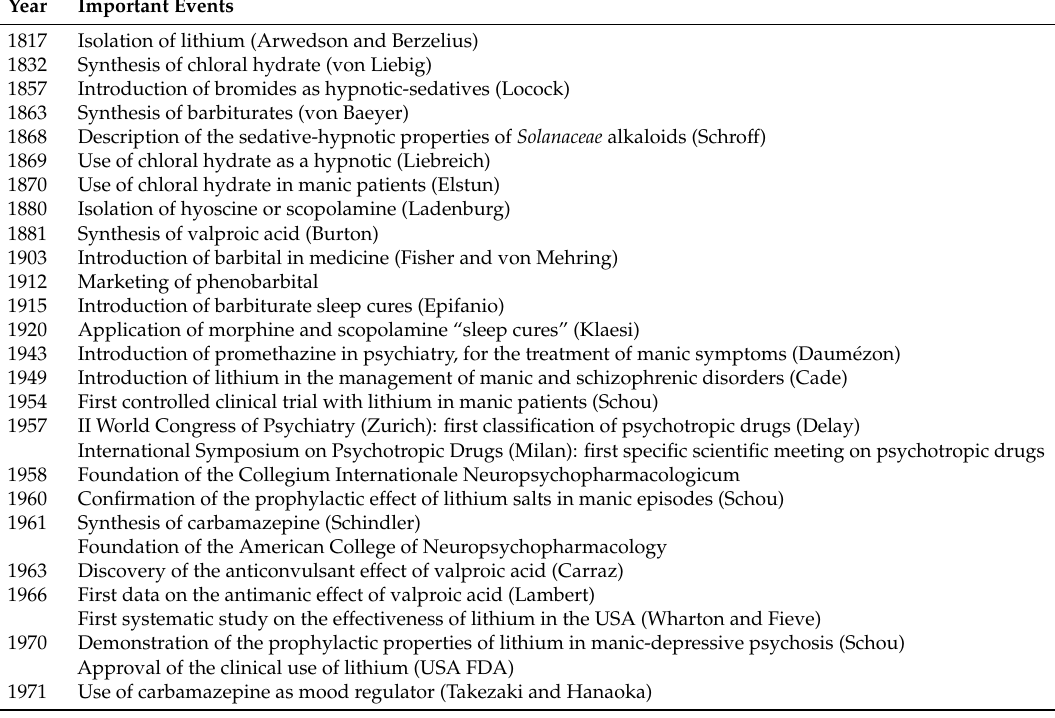
Table 1. Key milestones in the history of the pharmacological treatment of bipolar